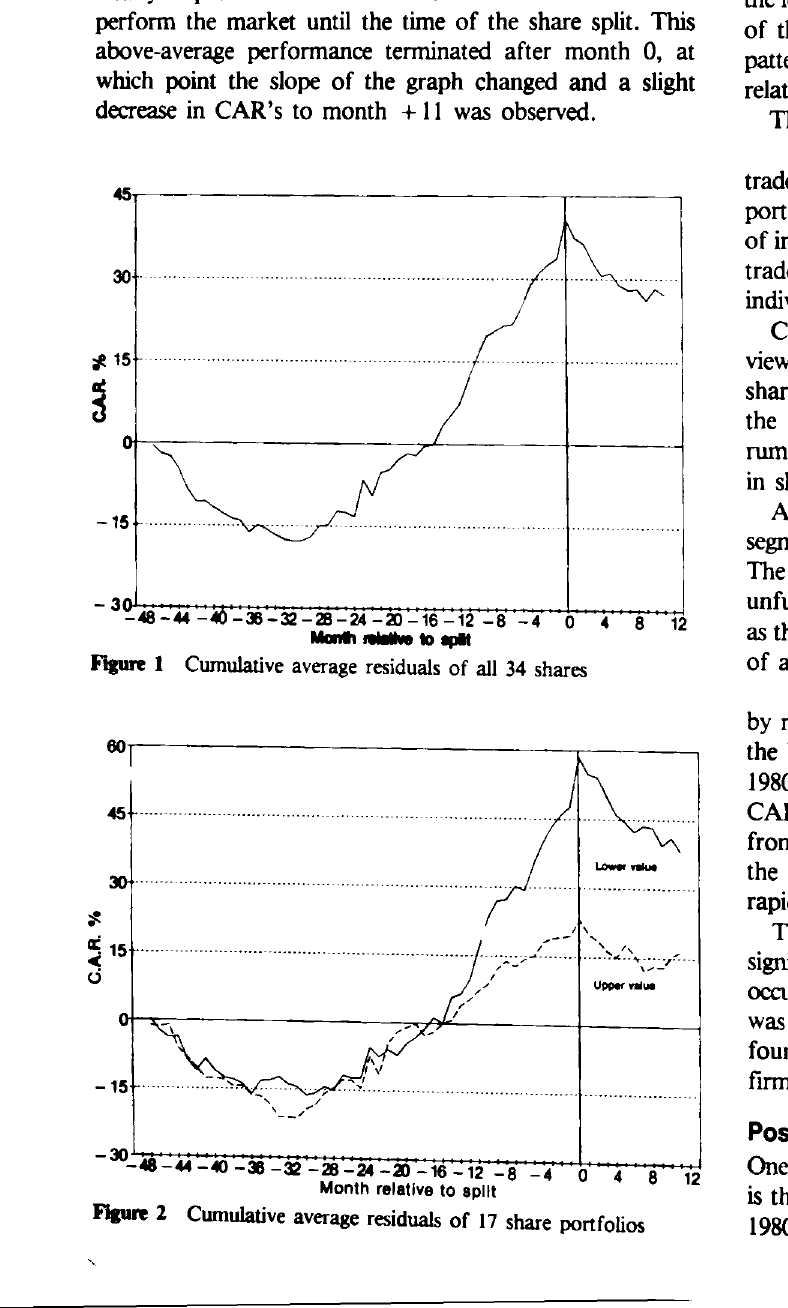
F..-,e 1 Cumulative average residuals of all 34